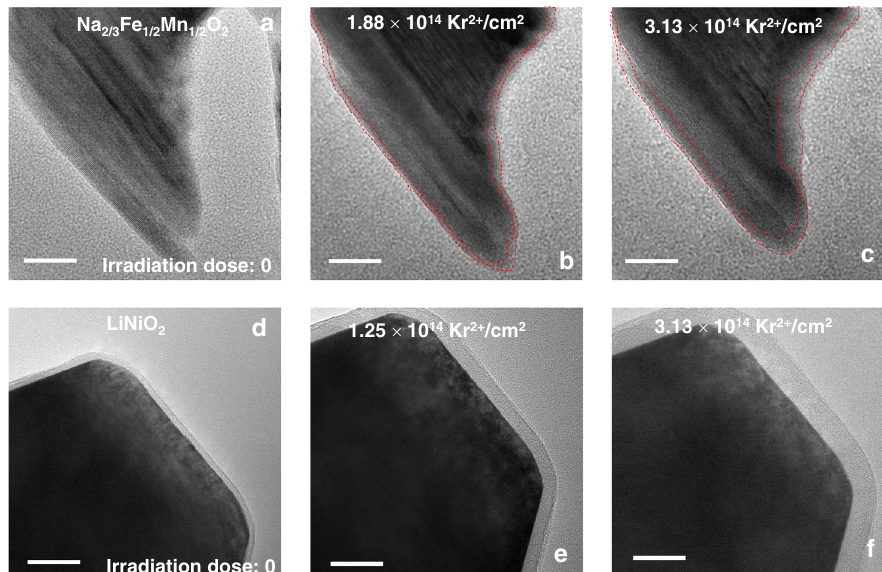
Fig. 3 TEM images of Na 2/3 Fe 1/2 Mn 1/2 O 2 and LiNiO 2 under Kr ion irradiation. a TEM image of Na 2/3 Fe 1/2 Mn 1/2 O 2 before irradiation. TEM images of Na 2/3 Fe 1/2 Mn 1/2 O 2 at the fl uence of b 1.88 × 10 14 Kr 2 + /cm 2 , and c 3.13 × 10 14 Kr 2 + /cm 2 at room temperature. The red dashed lines in ( b – c ) indicate the growth of the amorphous layer upon irradiation. d TEM image of LiNiO 2 before irradiation. TEM images of LiNiO 2 at the fl uence of e 1.25 × 10 14 Kr 2 + /cm 2 , and f 3.13 × 10 14 Kr 2 + /cm 2 at room temperature. All the scale bars correspond to a length of 20